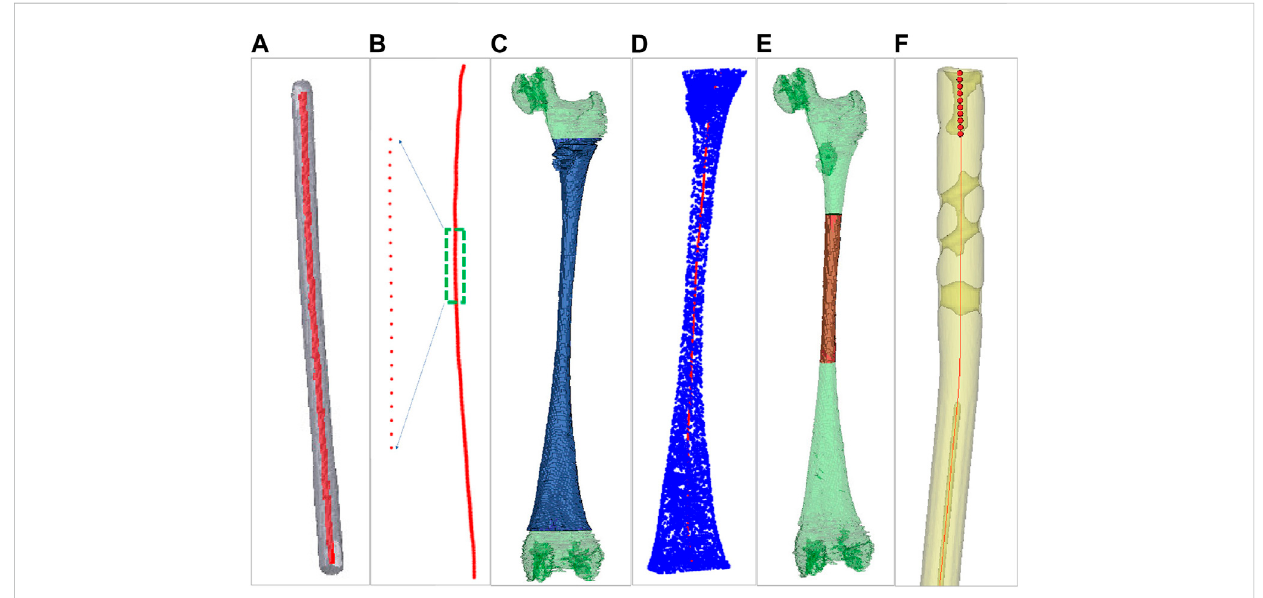
FIGURE 2 Centerlines extraction of the intramedullary nail and the medullary cavity. (A) Centerline extraction of the intramedullary nail. (B) Setting control points. (C) Green for the medullary cavity and blue for the interested part. (D) Centerline extraction of the interested part. (E) Green for the medullary cavity and red for the medullary cavity isthmus. (F) The ten continuous control points near the upper end of intramedullary nail